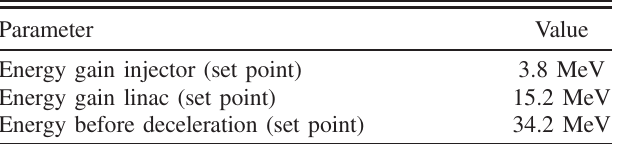
TABLE IV. Energies used for the twice-recirculating ERL test